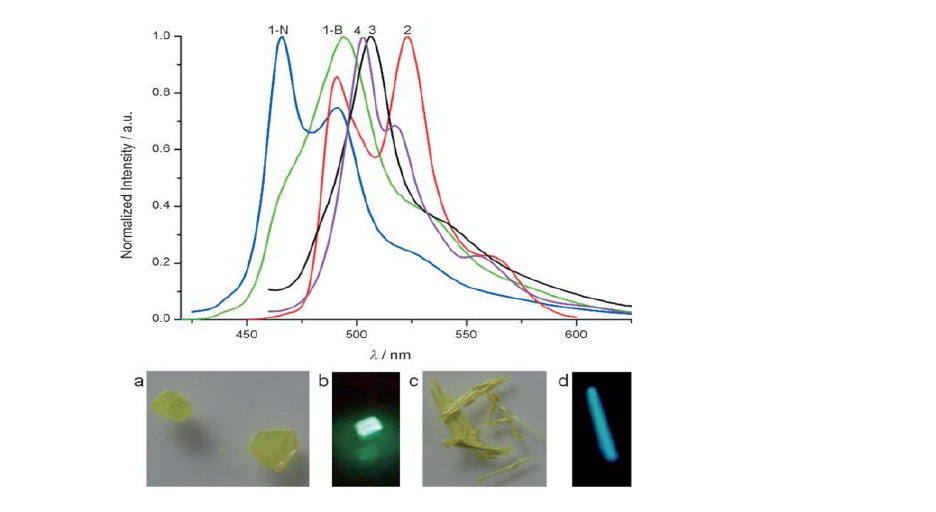
Figure 1. Top: solid-state emissions of complexes 15 – 18 at room temperature. Bottom: photographs of B-form and N-form crystals of 1 under natural light ( a , c ) and under 365 nm UV lamp ( b , d ).